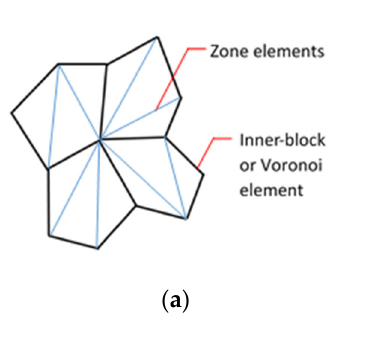
Figure 2. ( a ) Inner-blocks discretized into internal elements (zones); ( b ) contact point between blocks.